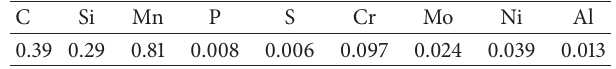
Table 1: Chemical composition of S38C steel (mass fraction, %).